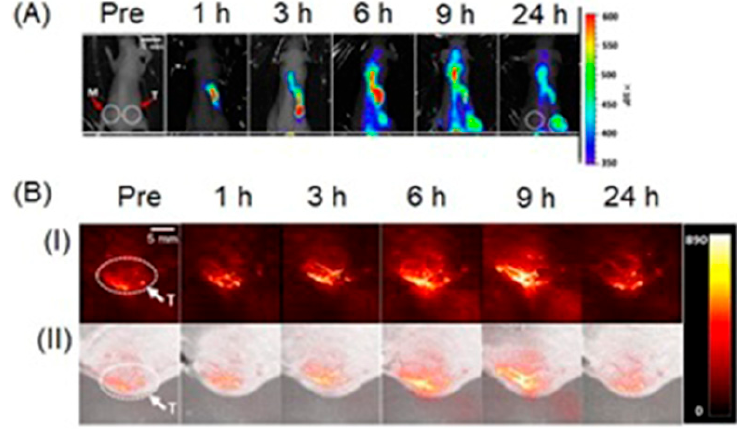
Figure 52. ( A ) Real-time fluorescence images of tumor-bearing mouse after administration of dye (100 µ M in 200 µ L of saline) at different time points. White dashed circles indicate the tumor site. M = muscle. T = tumor. ( B ) Photoacoustic images of A549 tumor-bearing mice were obtained before and 1, 3, 6, 9, and 24 h after injection of dye (100 µ M in 200 µ L of saline). (I) and (II) represent photoacoustic and merged images, respectively. White dashed circles indicate the tumor sites. T = tumor. Adapted with permission from Mu, H.; Miki, K.; Harada, H.; Tanaka, K.; Nogita, K.; Ohe, K. pH-activatable cyanine dyes for selective tumor imaging using near-infrared fluorescence and photoacoustic modalities. ACS Sens. , 2021 , 6 , 123–129. Copyright 2021 American Chemical Society [368].